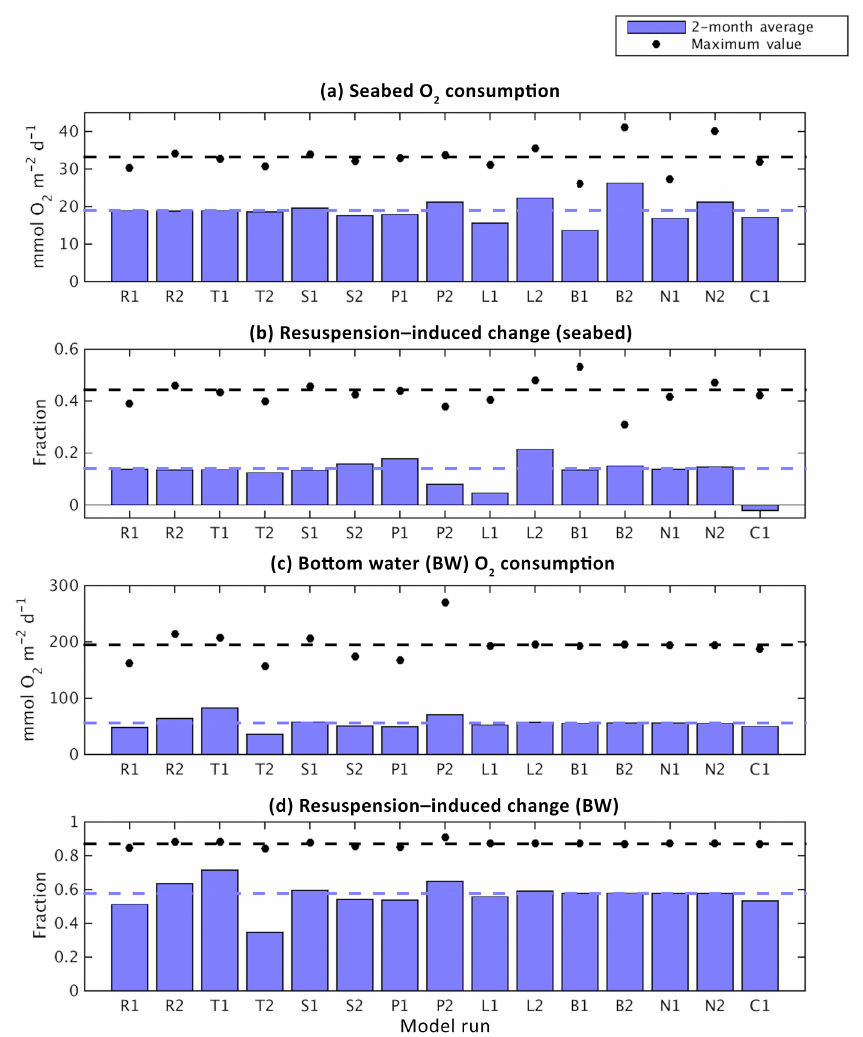
Figure 7. Rate of oxygen consumption in the (a) seabed and (c) bottom waters for each sensitivity test listed in Table 4. Fraction of (b) seabed and (d) bottom-water oxygen consumption induced by resuspension, calculated by dividing the difference between each sensitivity test and its no-resuspension model run by the value from the sensitivity test. In both panels, bars represent averages over 2 months. Dots indicate the maximum values during this 2-month period (which occurred during resuspension events). The dashed lines represent values from the standard model run, with the color of the line consistent with the type of data it represents (i.e., 2-month average or maximum